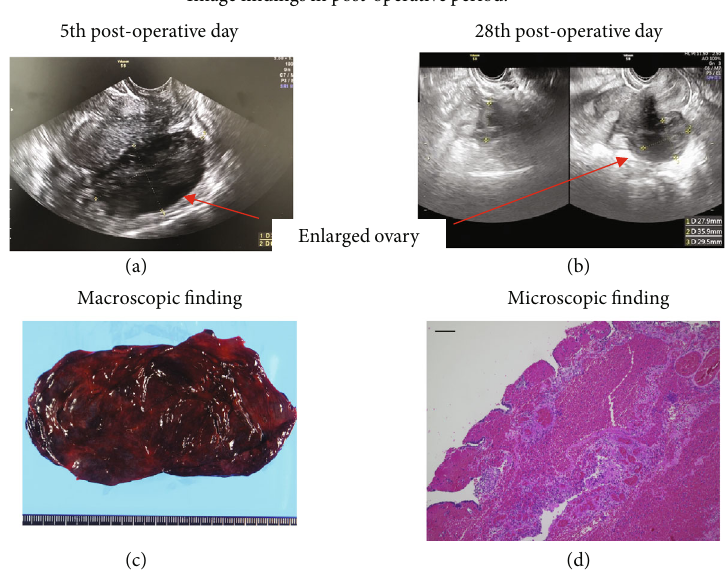
Figure 3: Image fi ndings in postoperative period. (a, b) Ultrasonography fi ndings. (a) An ultrasonography fi nding on 5th postoperative day. (b) An ultrasonography fi nding on 28th postoperative day. Arrows: left ovary. (c, d) Pathological fi ndings. (c) Macroscopically, cyst was fi lled with blood. (d) Microscopically (40x), extensive necrosis and congestion of the cyst wall with some preserved fallopian tube epithelium were observed. Scale bar: 100 μ